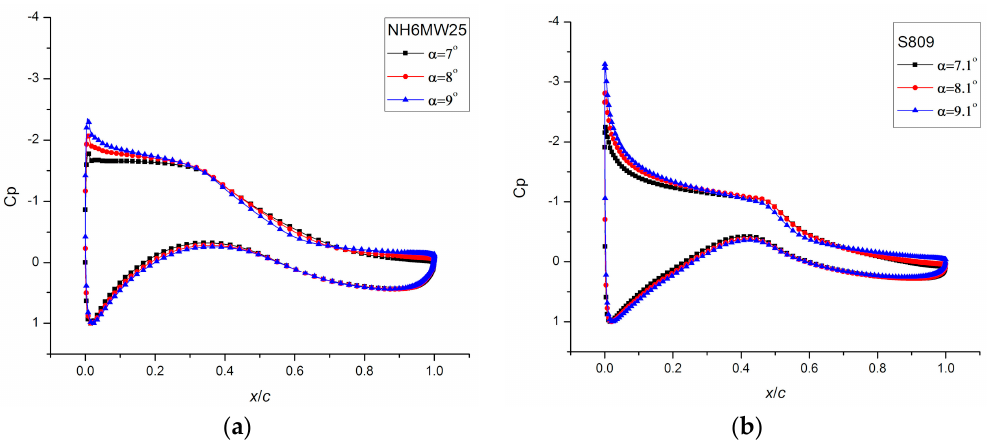
Figure 18. Pressure coefficient distributions over two airfoils at Re = 1 × 10 6 and m = 0%: ( a ) NH6MW25 airfoil; ( b ) S809 airfoil.